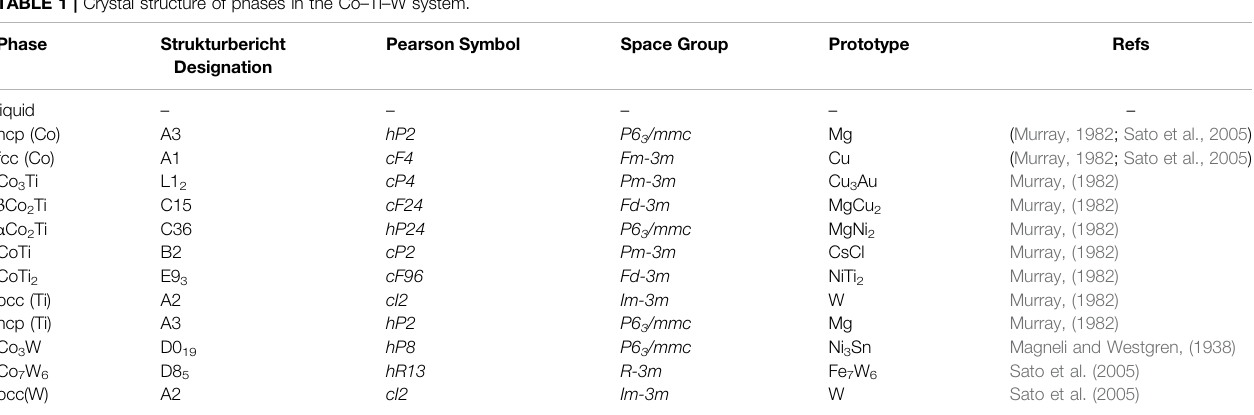
TABLE 1 | Crystal structure of phases in the Co – Ti – W